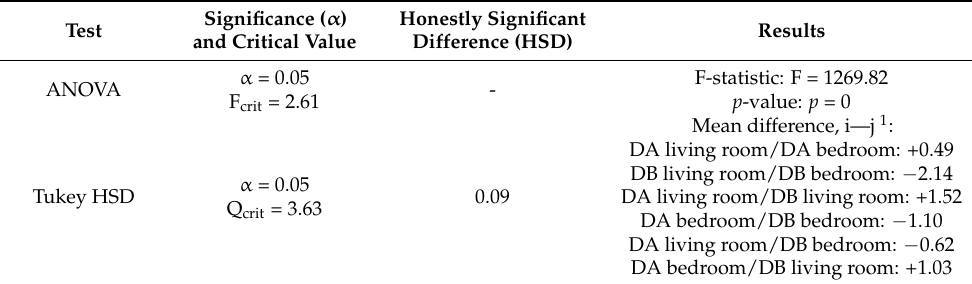
Table 5. Significant results from one-way ANOVA tests and post hoc Tukey’s HSD test.